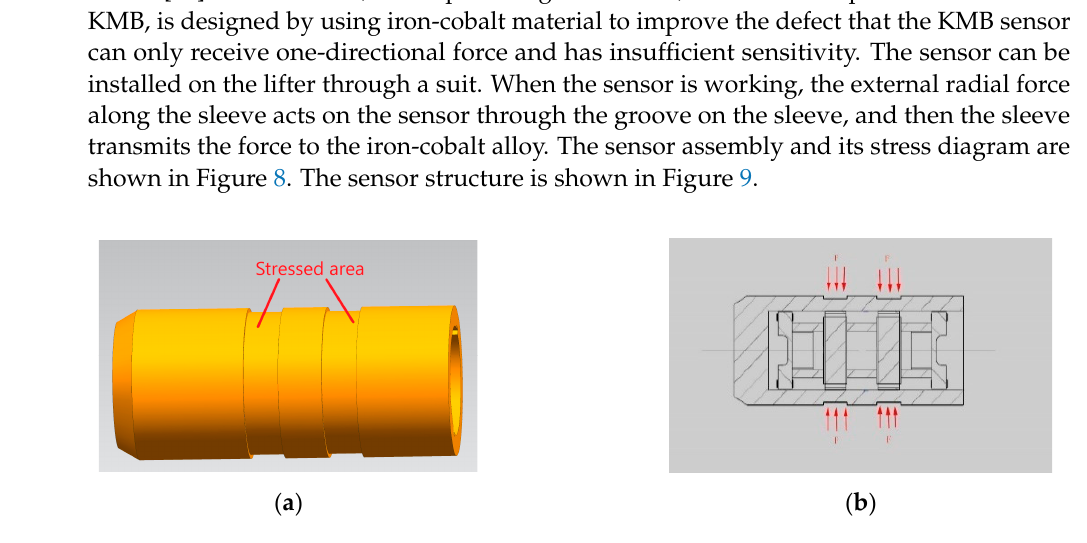
Figure 8. Assembly and stress diagram of piezomagnetic sensor. ( a ) Stress area diagram of sleeve, ( b ) Force diagram of sensor.